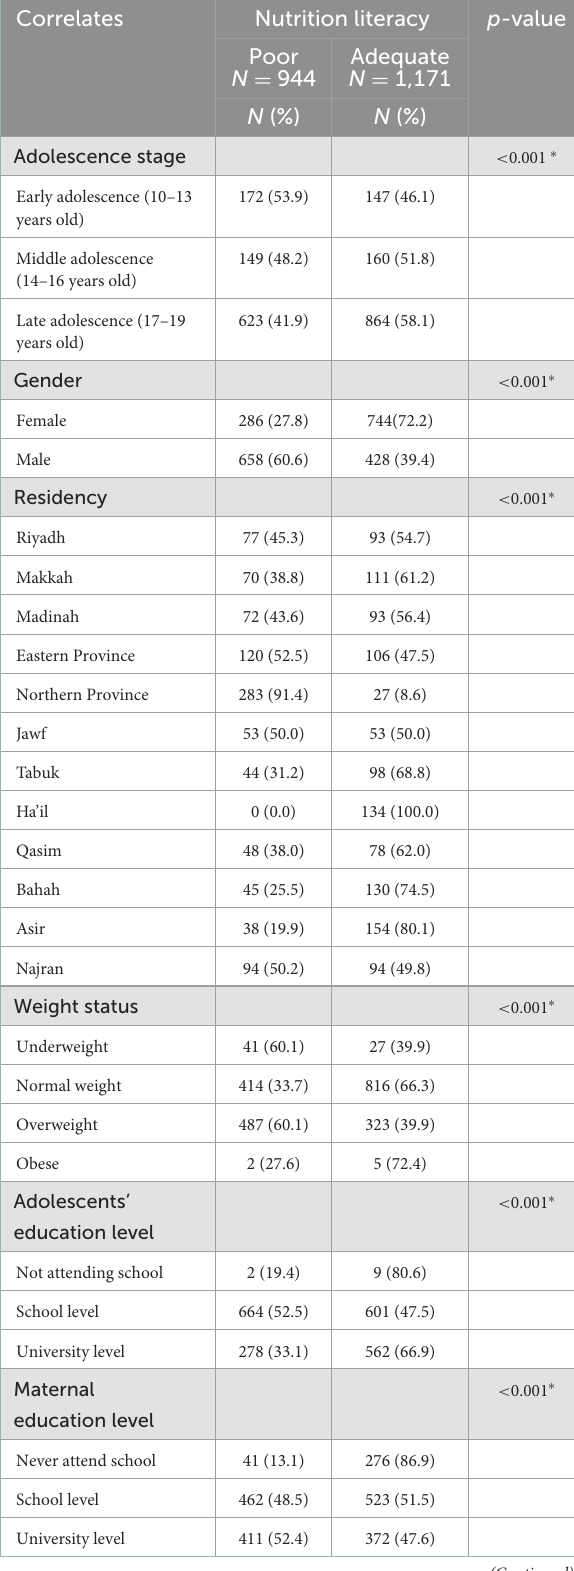
TABLE 4 The correlations associated with the adolescents’ nutrition literacy status.